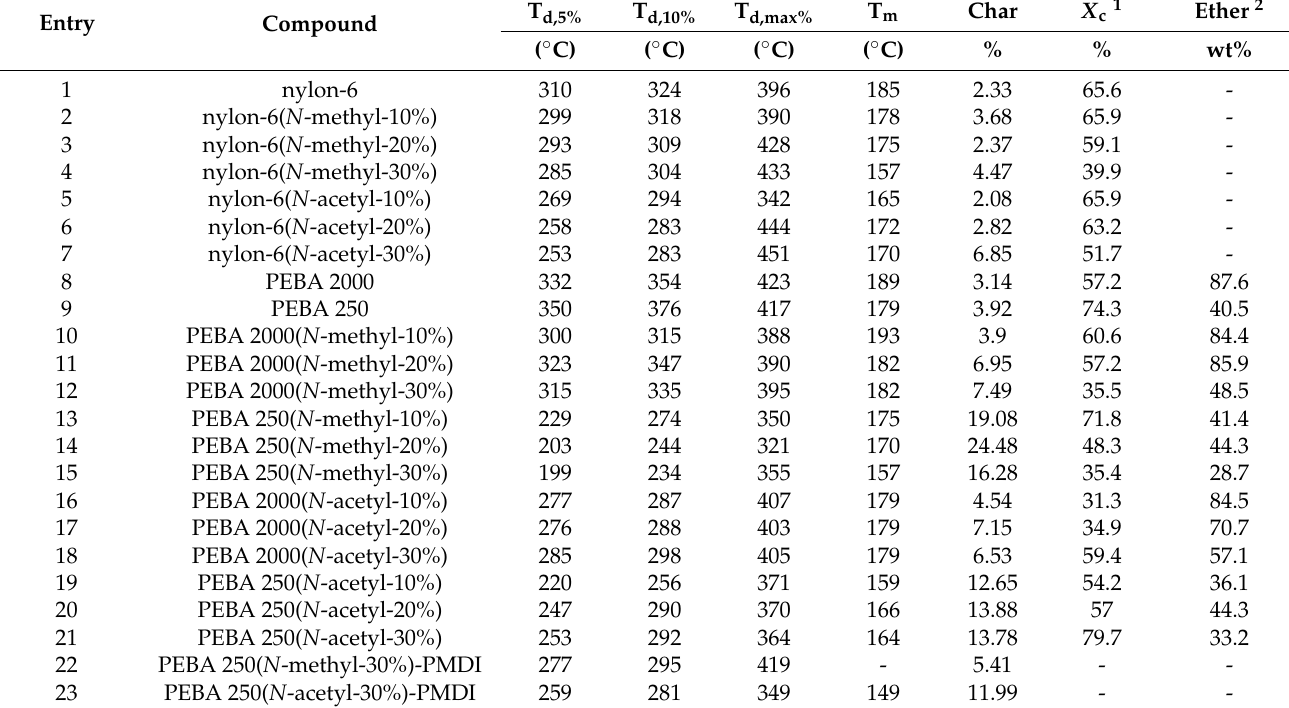
Table 2. Thermal properties of Nylon, PEBA, PEBA( N -methyl-X%), and PEBA( N